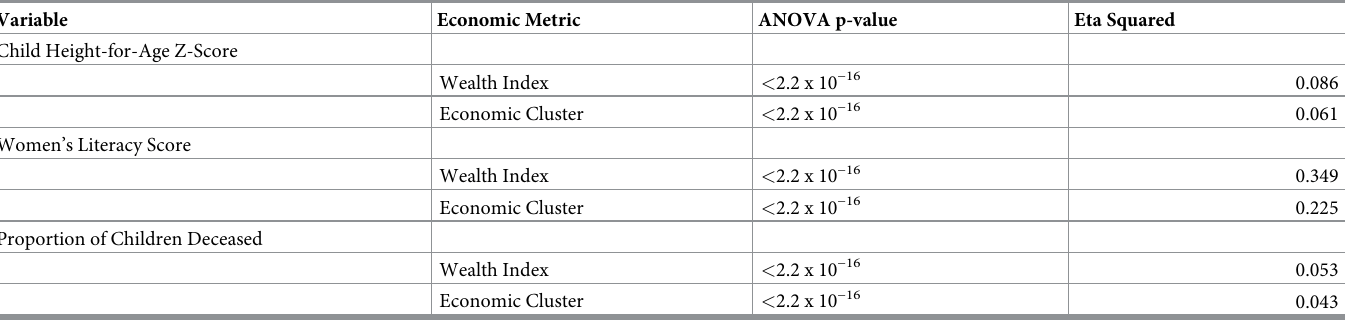
Table 1. Results of ANOVA and eta squared comparing proportion of variance in child height-for-age Z-score, women’s literacy score, and proportion of children who are deceased accounted for by Cameroonian DHS Wealth Index and EconomicClusters models.